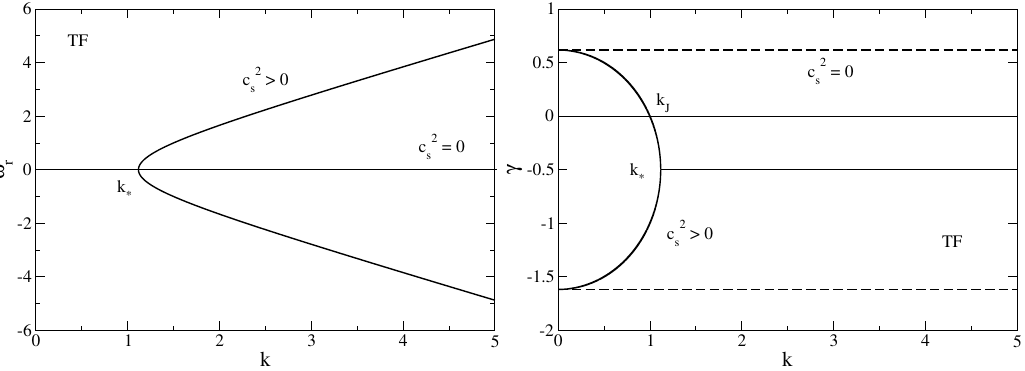
Figure 13. Dispersion relation for self-gravitating BECs in the TF limit (¯ h = 0) when c 2 s ≥ 0. We have normalized the wavenumber by ( 4 π G ρ / c 2 s ) 1/2 and the pulsation and the friction by ( 4 π G ρ ) 1/2 . This is equivalent to taking 4 π G = ρ = m = c s = 1 in the dimensional equations. We have selected ξ =